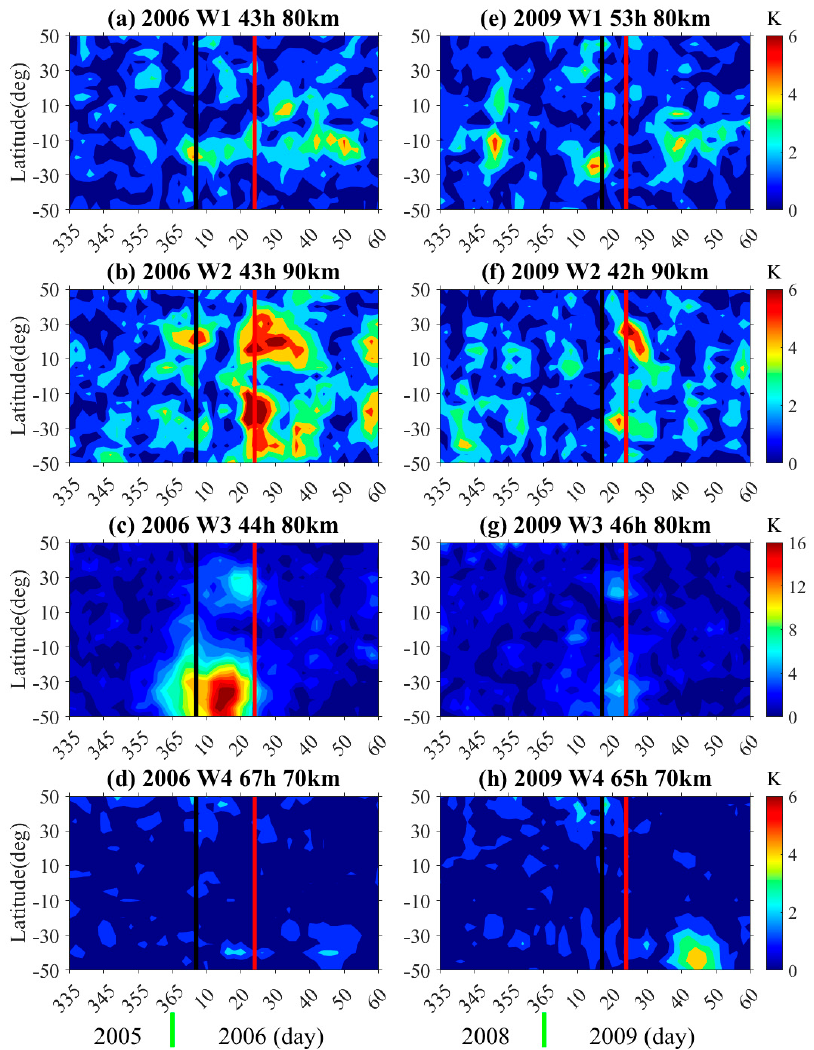
Figure 2. Temporal and latitude variation of the W1, W2, W3, and W4 during 2006 ( a – d ) and 2009 ( e – h ). The vertical black and red lines indicate the starting of the sudden stratospheric warming and the warming peak of the sudden stratospheric warming.